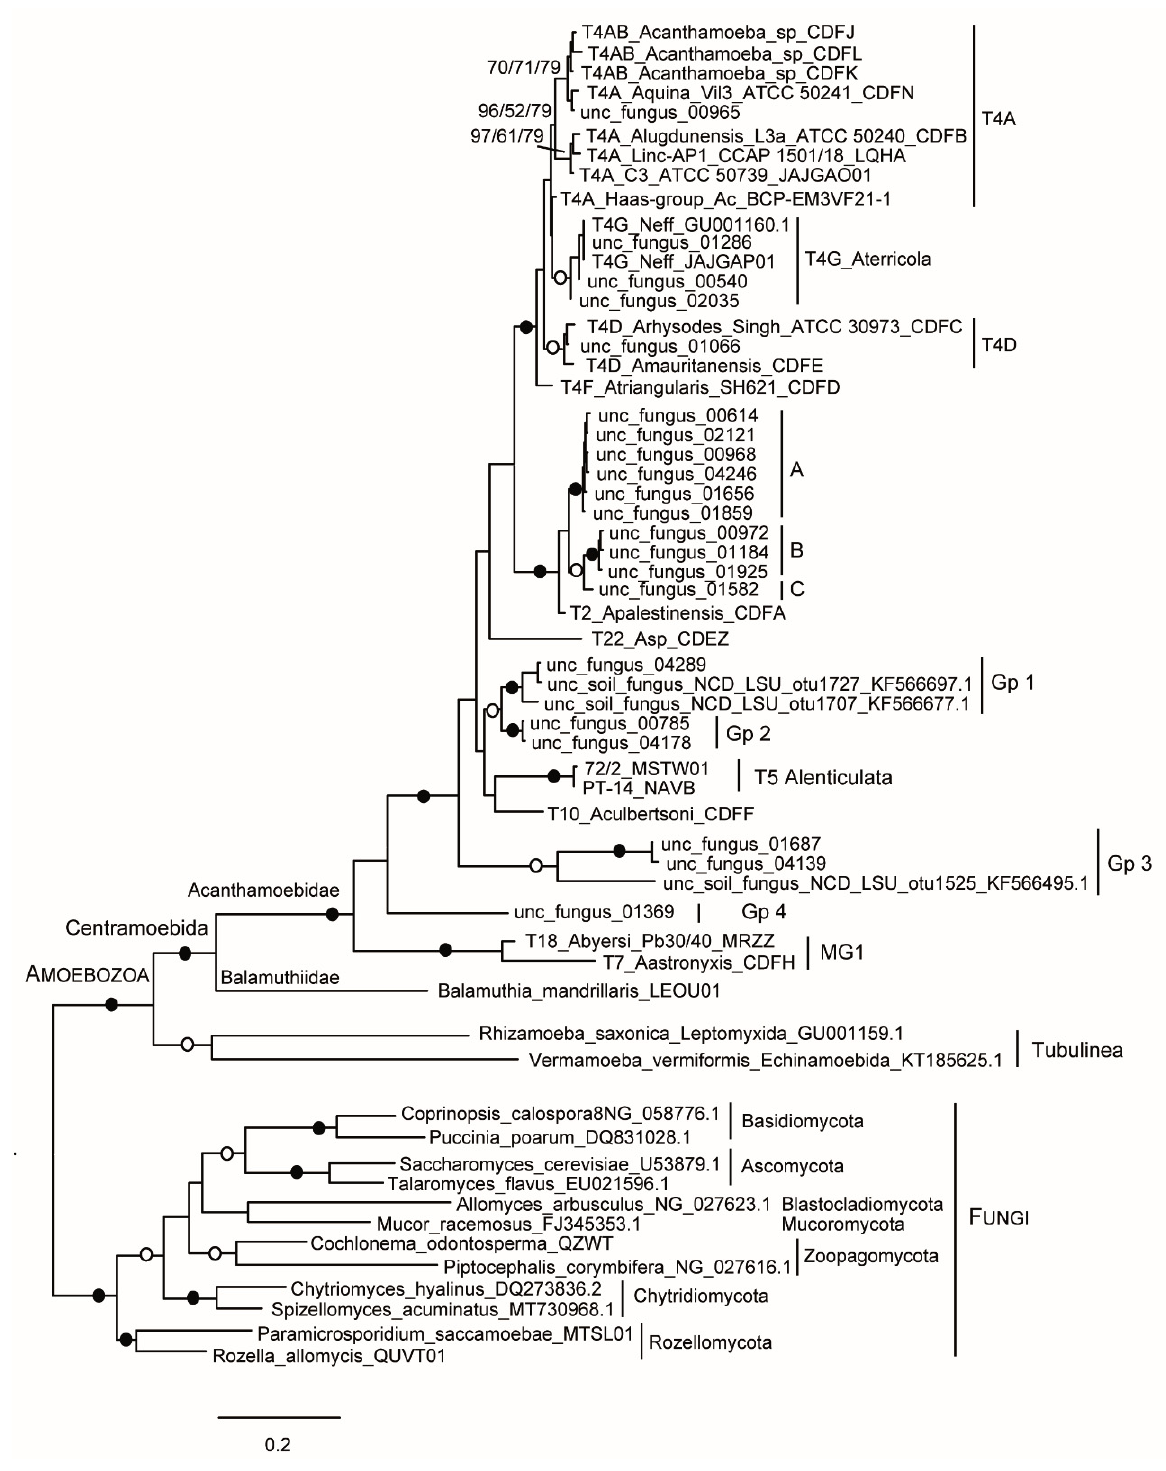
Figure 2. Molecular phylogeny based on LSU rDNA. The analysis includes complete LSU rDNA sequences for Acanthamoeba spp., the close relative Balamuthia mandrillaris ; more distant amoebae belonging to the class Tubulinea; and main lineages of the fungal kingdom. For uncultured “fungal” clones, only partial sequences are available. At the nodes, there are bootstrap values (1000 replicates) for ML/NJ/MP, with filled and open circles for values 100 or >90% with all the methods. Five clones emerge within Acanthamoeba T4, closely related to A. quina (T4A), A. ter-